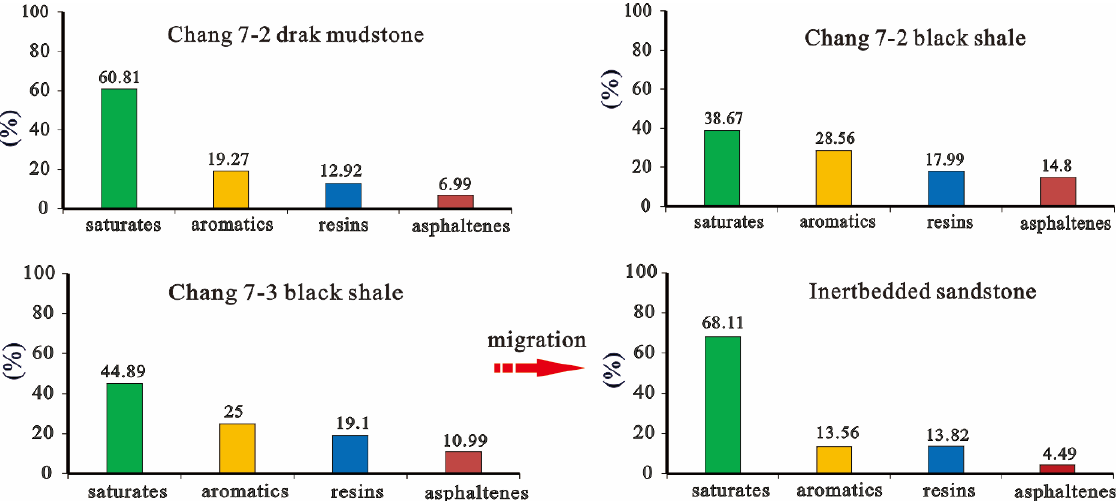
Figure 12. The distribution of saturate, aromatic, resin and asphaltene fractions in partial samples from well CYX.